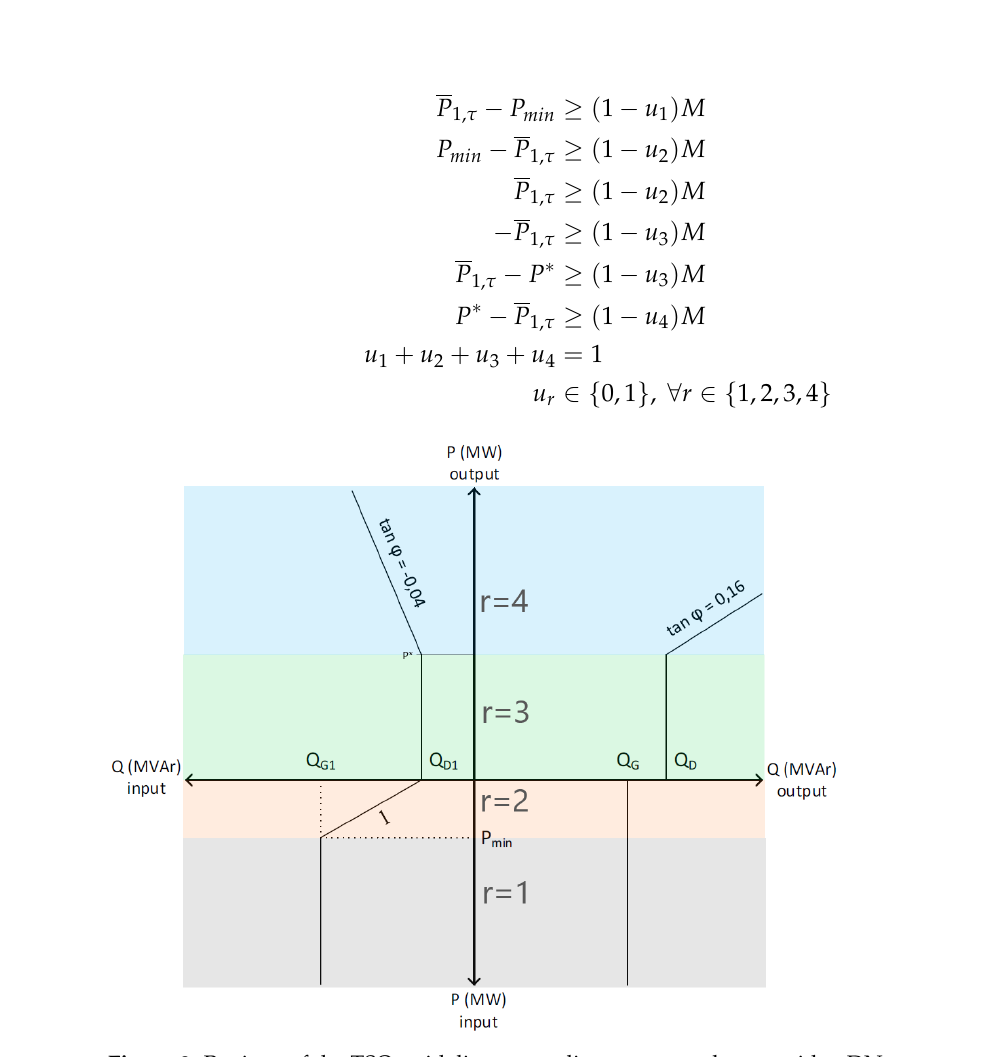
Figure 3. Regions of the TSO guidelines regarding power exchange with a